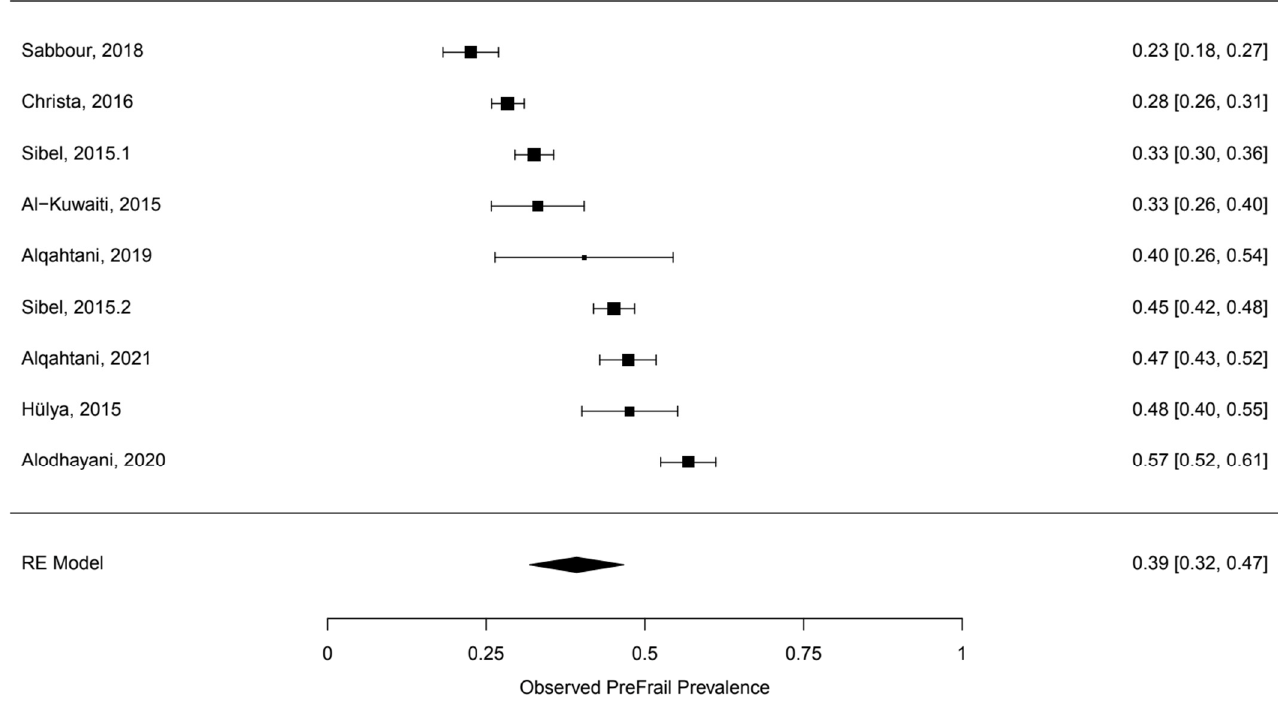
Figure 2. Forest plot of the observed pre-frail prevalence.